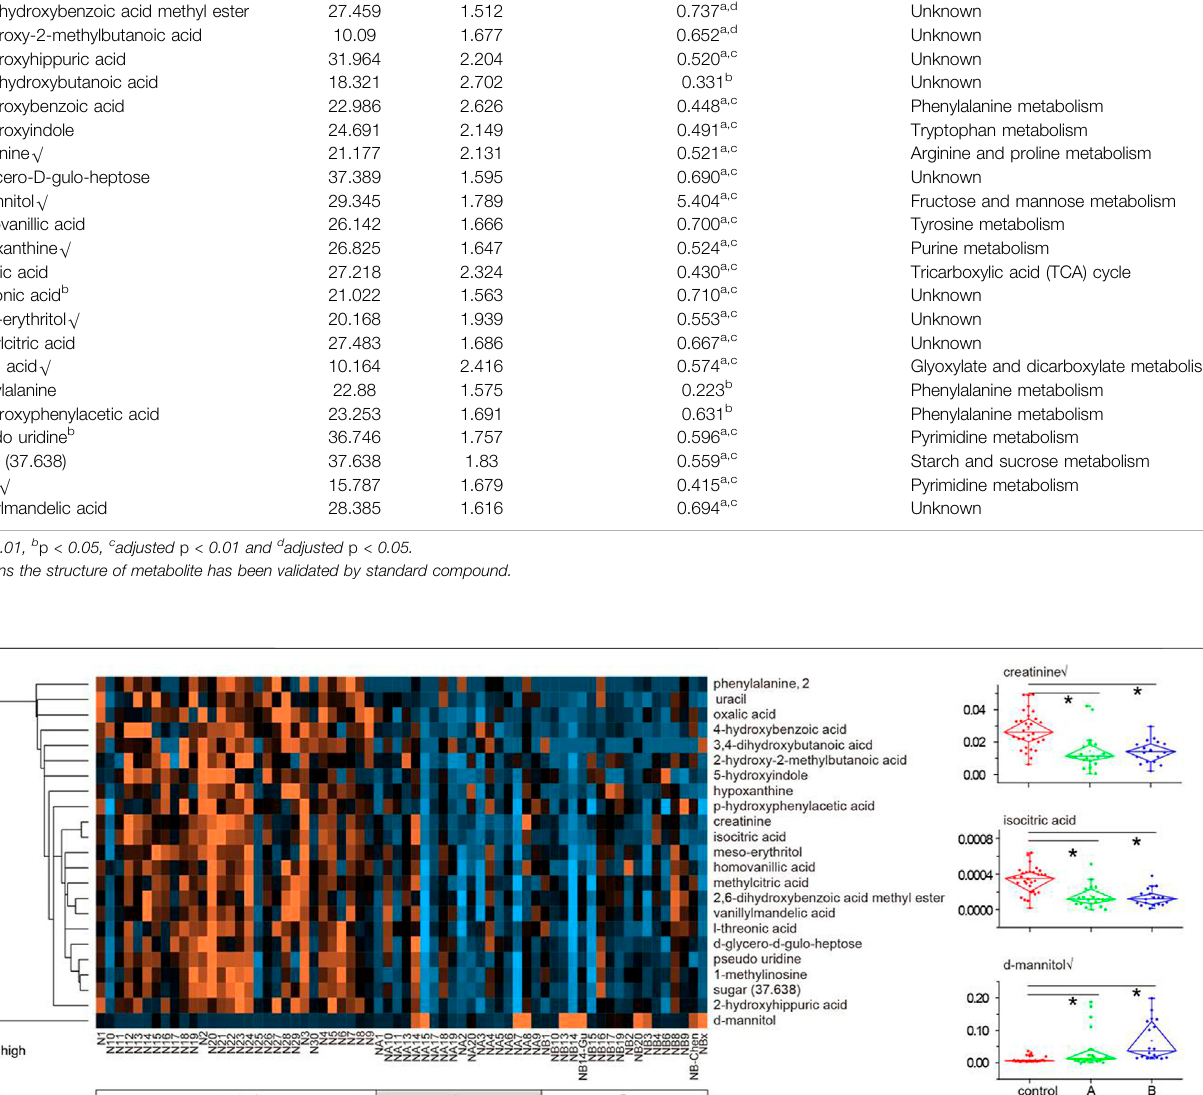
TABLE 2 | Characterization of the signi fi cantly different metabolites between the healthy subjects and LDH patients. Compounds RT VIP Fold change (patients/control) Main metabolic pathway 1-methylinosine